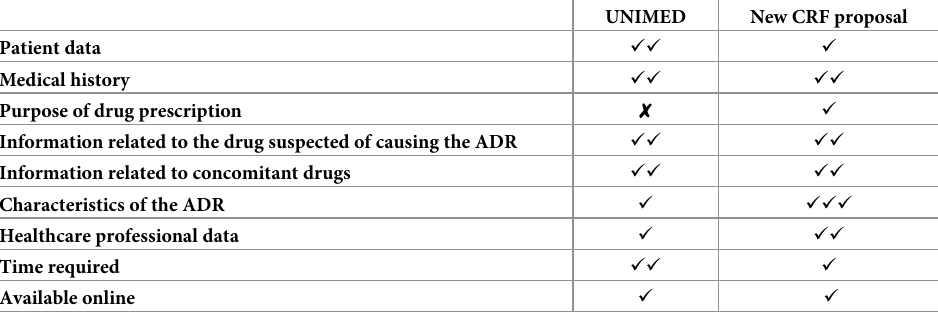
Table 2. Summary of the main characteristics of the CRF established by UNIMED and the new proposed CRF. The new CRF form was based on the follow-up form used by the Bolivian Chagas Platforms, the CRF established by UNIMED, and CRFs used in other countries in the region. Increasing the information regarding the characteristics of ADRs was considered to be particularly important.